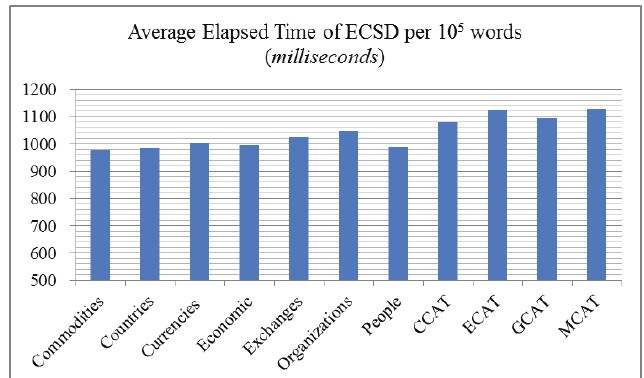
Fig.6 Average elapsed time of ECSD in four experimental tracks. (a) The elapsed time is not sensitive to domains or groups, ranging from 979ms to 1128ms. (b) Texts of RCV1-v2 costs slightly more time in average than those of